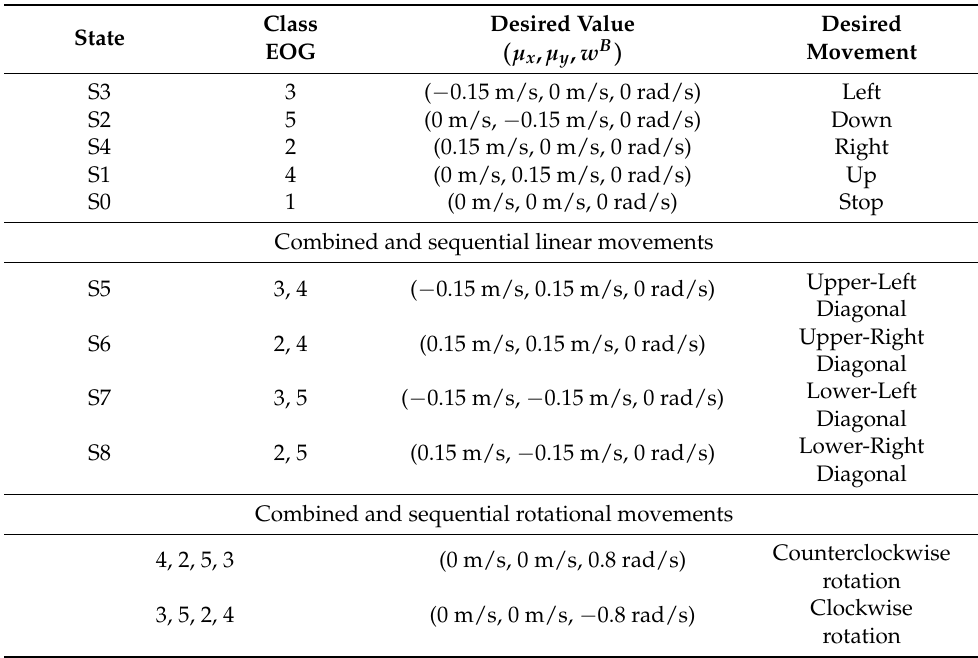
Table 3. Description of each of the movements in the state